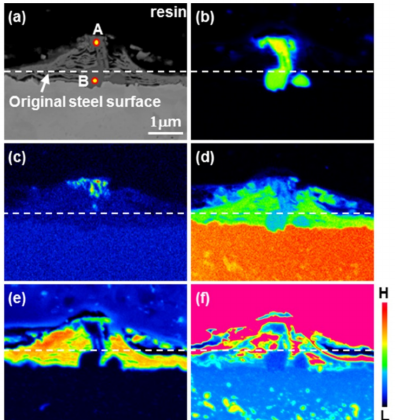
Figure 3. ( a ) BSE image; ( b – f ) Results of the EPMA area analysis of the specimen (Figure 1c) hot dipped for 10 s: ( b ) Al, ( c ) Ni, ( d ) Fe, ( e ) O, and ( f )